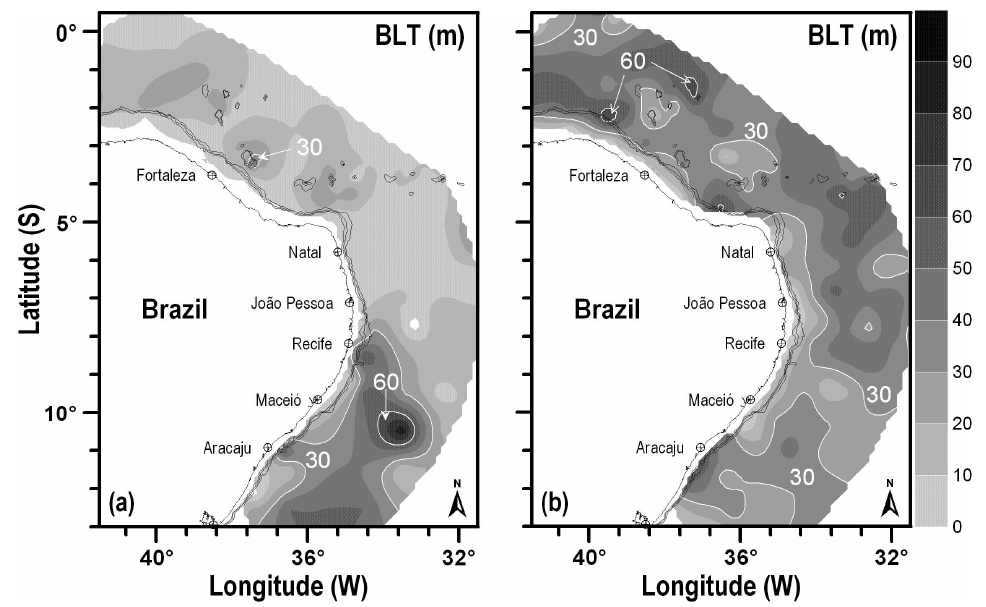
Fig. 6. Spatial distribution of barrier layer thickness (BLT) during: (a) late austral winter (August–October 1995); and (b) austral summer (January–April